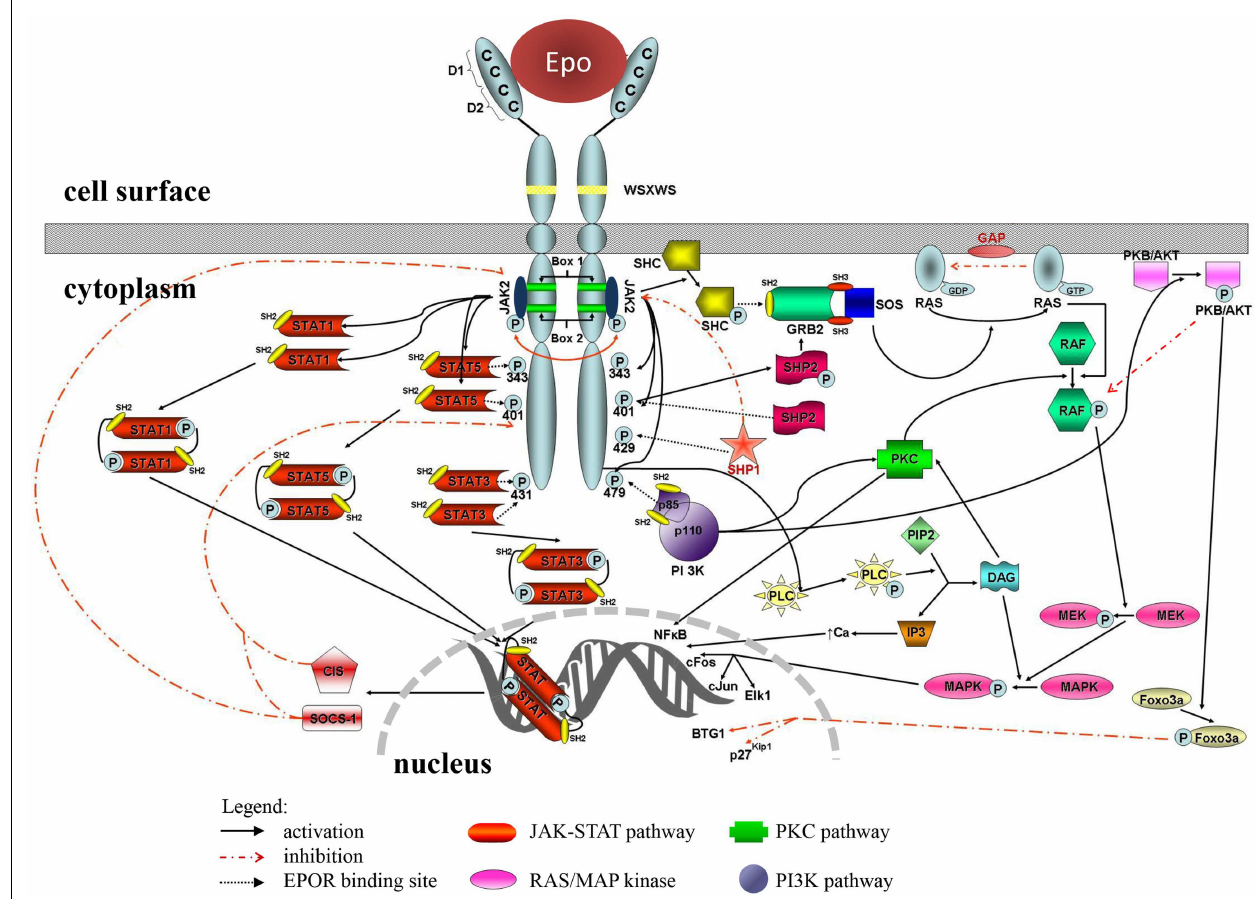
FIGURE 1 | Erythropoietin receptor and signaling pathways .The structure of the receptor dimer is outlined; docking sites for several intracellular proteins are marked with P and linked with black-dotted arrow to individual pathway components. Positive interactions are presented with full black arrows, negative with dotted